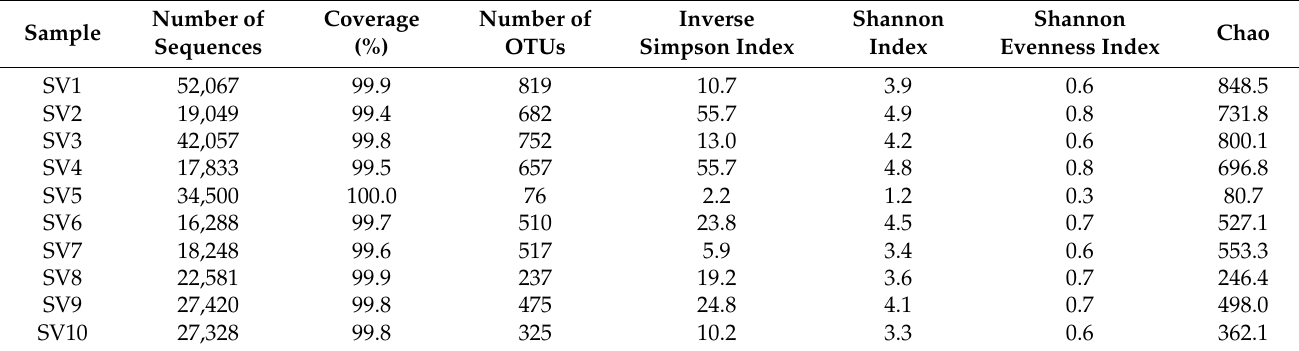
Table 2. Illumina sequencing statistical results and diversity indexes for domain Bacteria